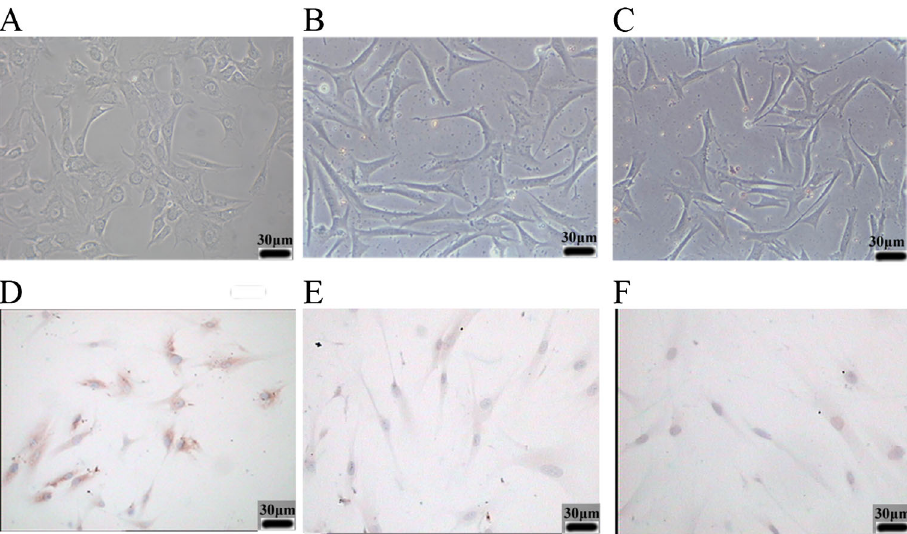
Figure 1. Effect of AGE-BSA on cell morphology and RAGE expression of human periodontal ligament fibroblasts (PDL fibroblasts). Relative to control cells ( C ), 48-h treatment with AGE-BSA altered cell morphology and reduced the number of cells ( A ). BSA-treated cells ( B ) were similar to control cells ( C ). Similarly, immunocytochemistry indicated that cells treated with AGE-BSA for 48 h had significantly greater expression of RAGE ( D ) than BSA-treated cells ( E ) and control cells ( F ). Magnification, 400 6 .